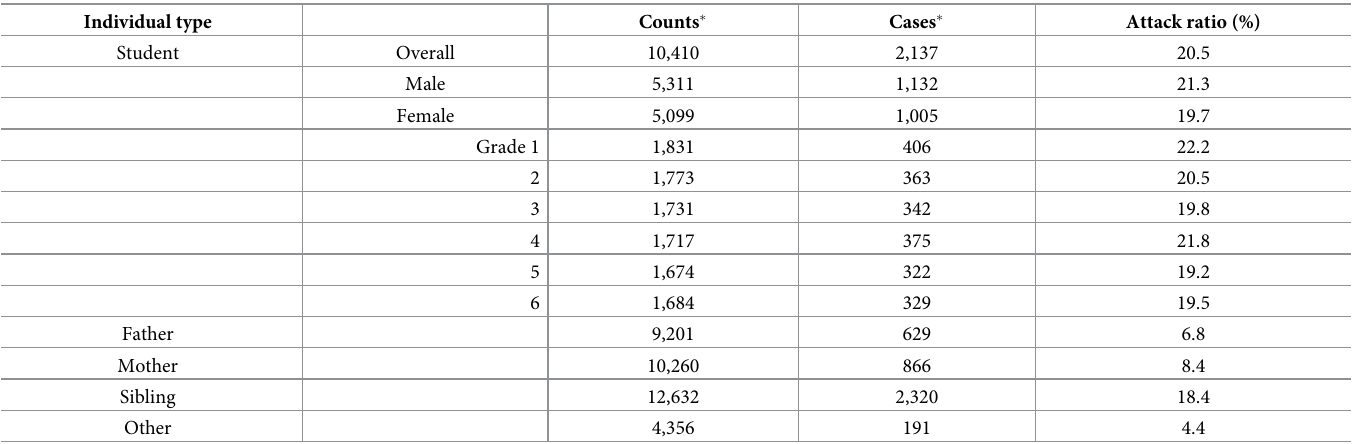
Table 1. The number of individuals and influenza cases in each